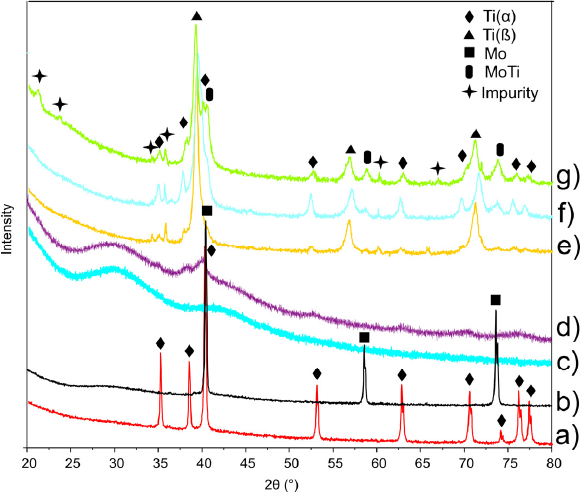
Figure 2. X-ray diffraction spectra of Ti ( a ); Mo ( b ) and 45S5 Bioglass ( c ) powders, their mixture after 30 h of mechanical alloying ( d ); and after annealing at 800 °C for 0.5 h: Ti23Mo ( e ); Ti23Mo 3BG ( f ); Ti23Mo 10BG ( g